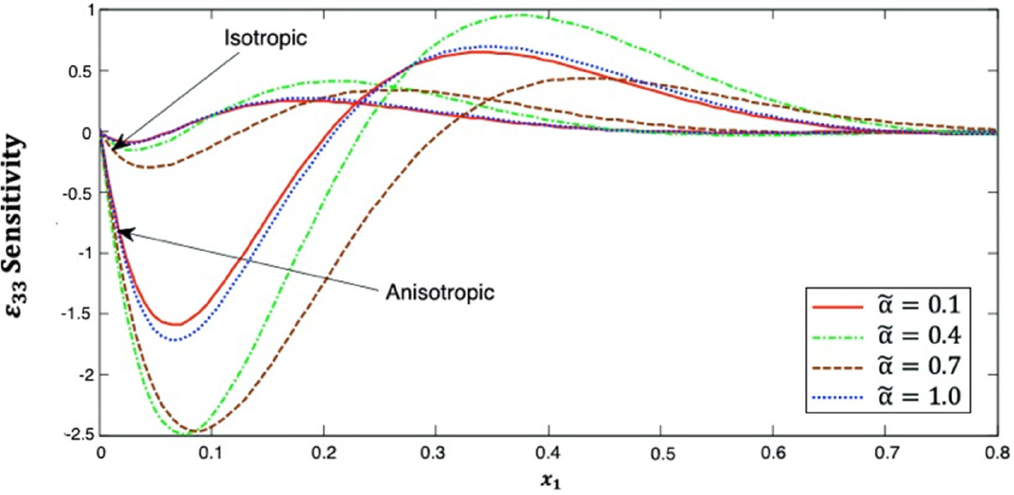
Figure 13. Distribution of the ε 33 sensitivity along x 1 –axis in isotropic and anisotropic FRP composites for various fractional-order values.